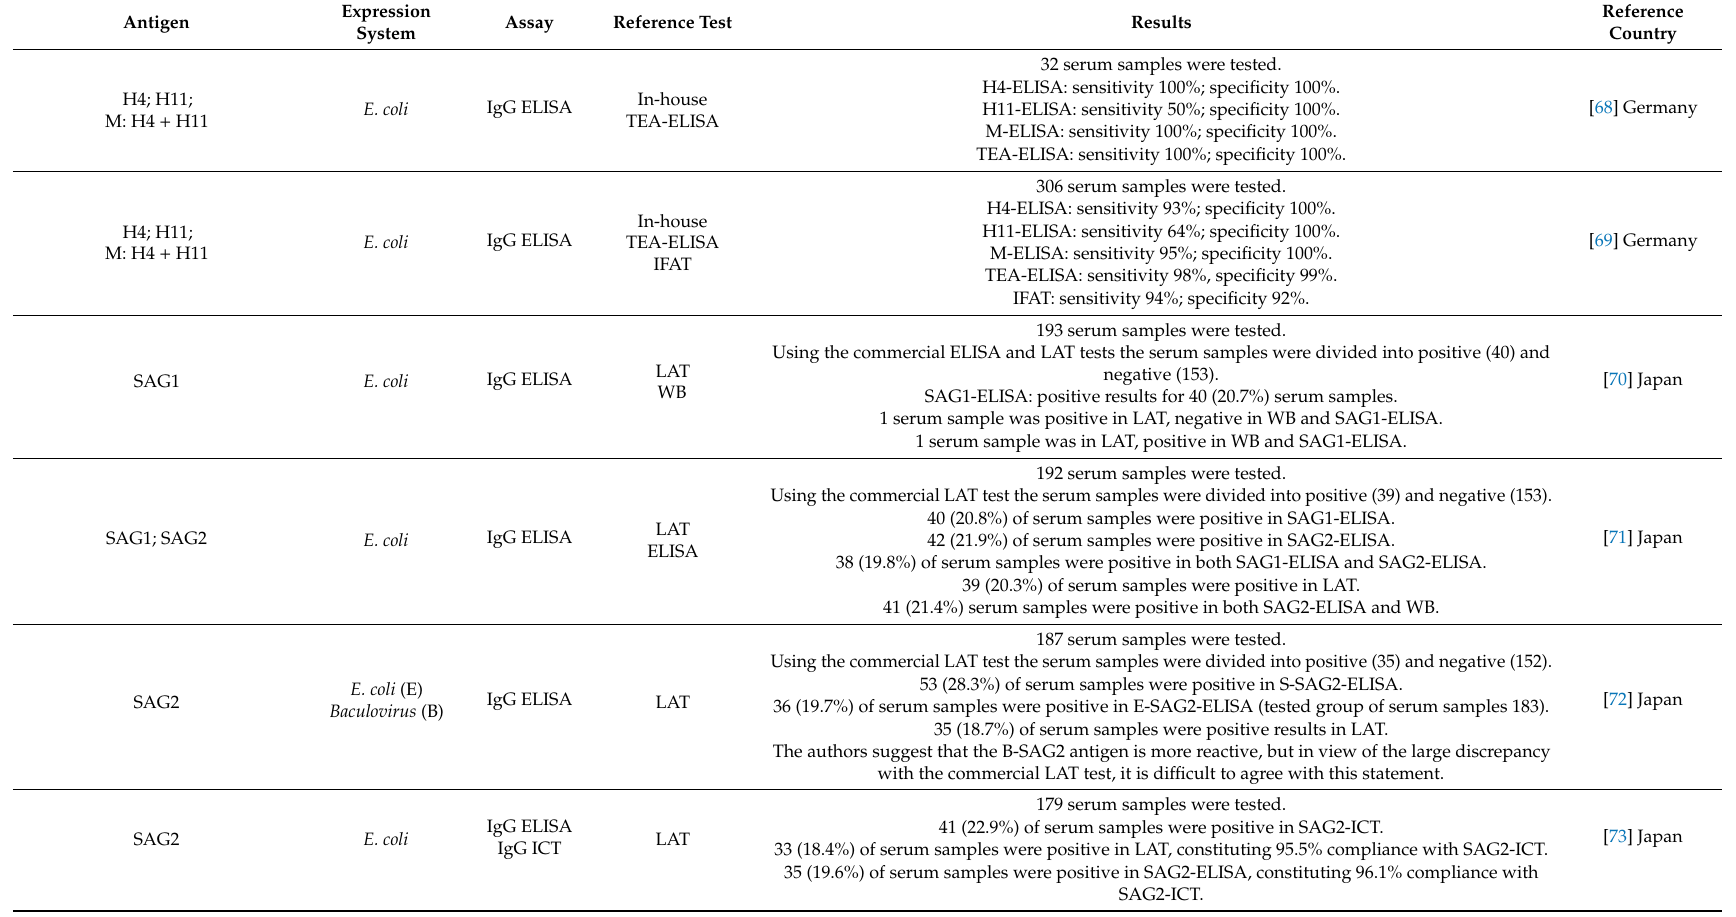
Table 2. Recombinant antigens used in detection of anti -T. gondii antibodies in feline serum